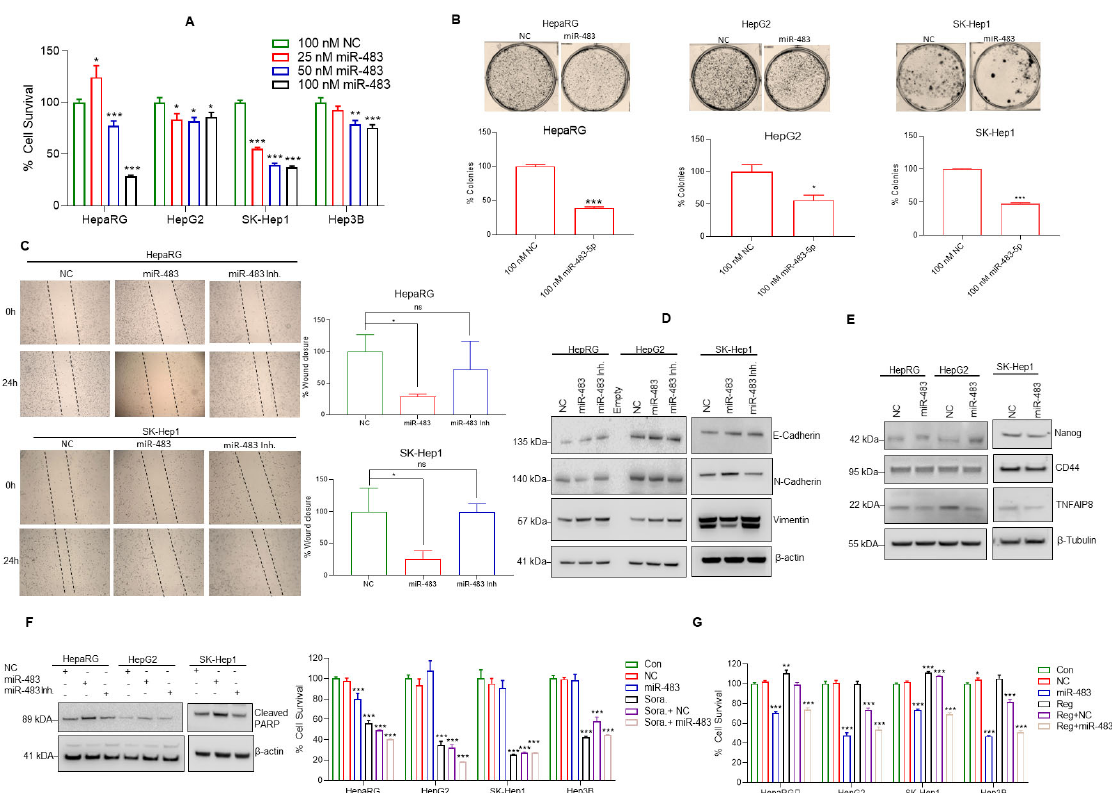
dependent overexpression of miR-483 inhibits cell survival in HepaRG (72%), HepG2 (14%), SK-Hep1 (63%), and Hep3B (14%) compared with NC (100 nM) transfected cells (Figure 3A). Cell colony formation assay showed that miR-483 inhibits HepaRG (61%), HepG2 (54%), and SK-Hep1 (56%) cell colony formation (Figure 3B, upper and lower panels).